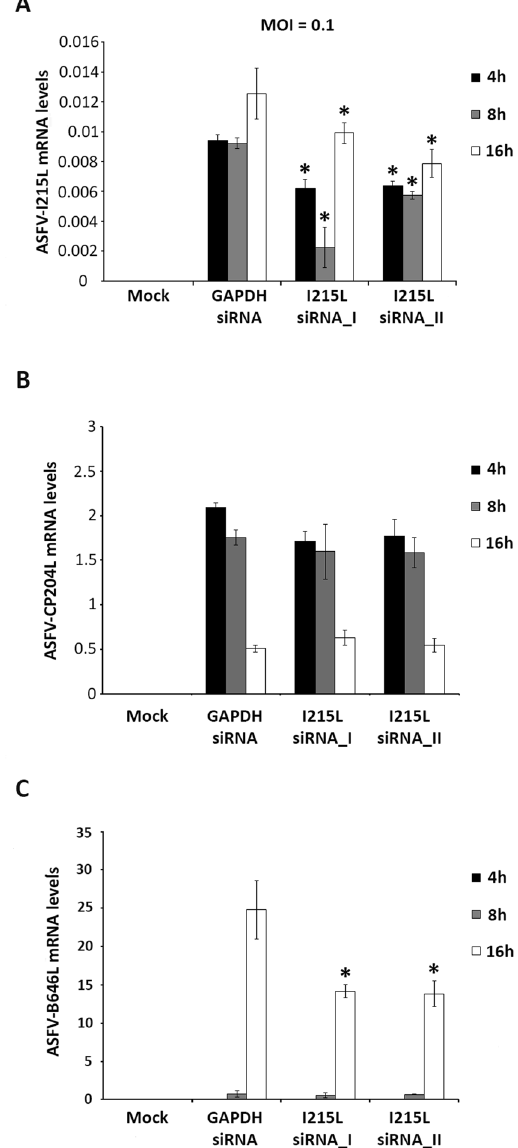
Figure 3. siRNAs targeting I215L disrupt late viral transcription. (A) siRNAs against I215L significantly reduced its mRNA levels at 4, 8 and 16 hpi in comparison to the infected control (p ≤ 0.05). I215L-depleted cells showed significantly lower mRNA levels of the ASFV B646L late gene (p ≤ 0.05) (C) , although the mRNA levels of the early viral gene CP204L (vp32) remained similar to the levels detected in control group (B) . Results are shown as average ± standard error (AVG ± S.E.), between the number of molecules of each viral transcript and the number of Cyclophilin A transcripts (housekeeping gene). Data were obtained from three independent experiments run in